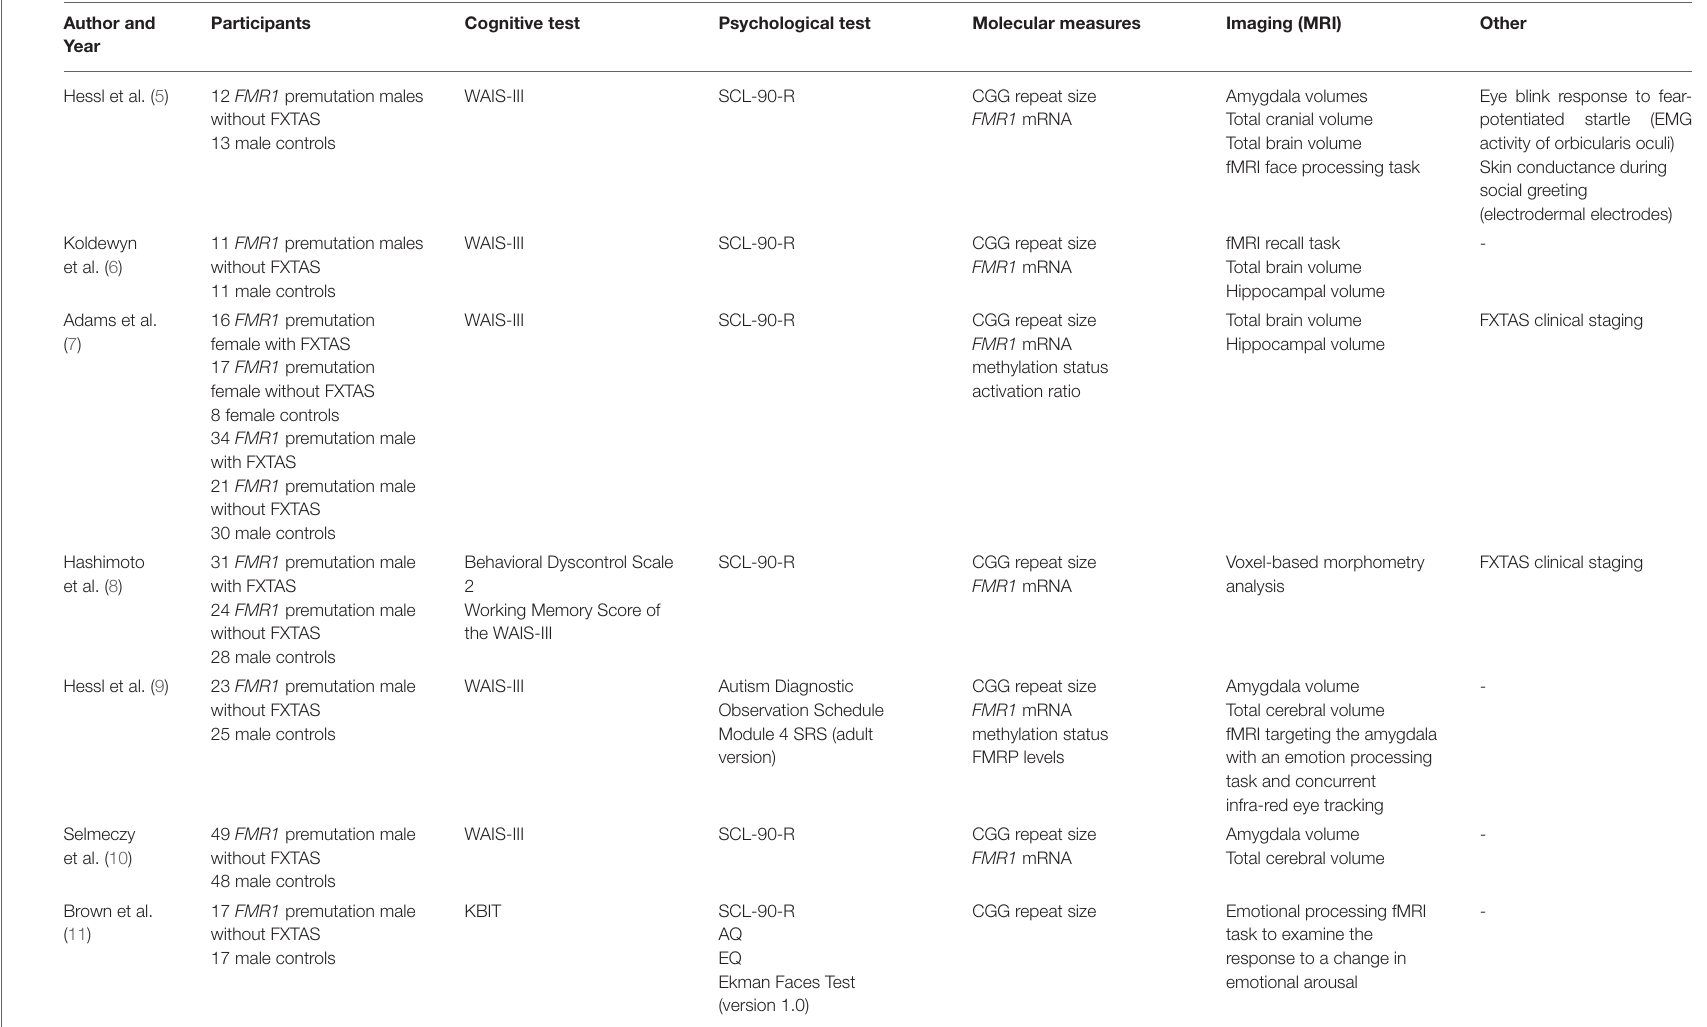
TABLE 1 | Summary of the reviewed